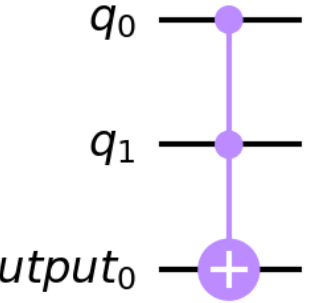
Figure 4. Quantum circuit logic AND operation.